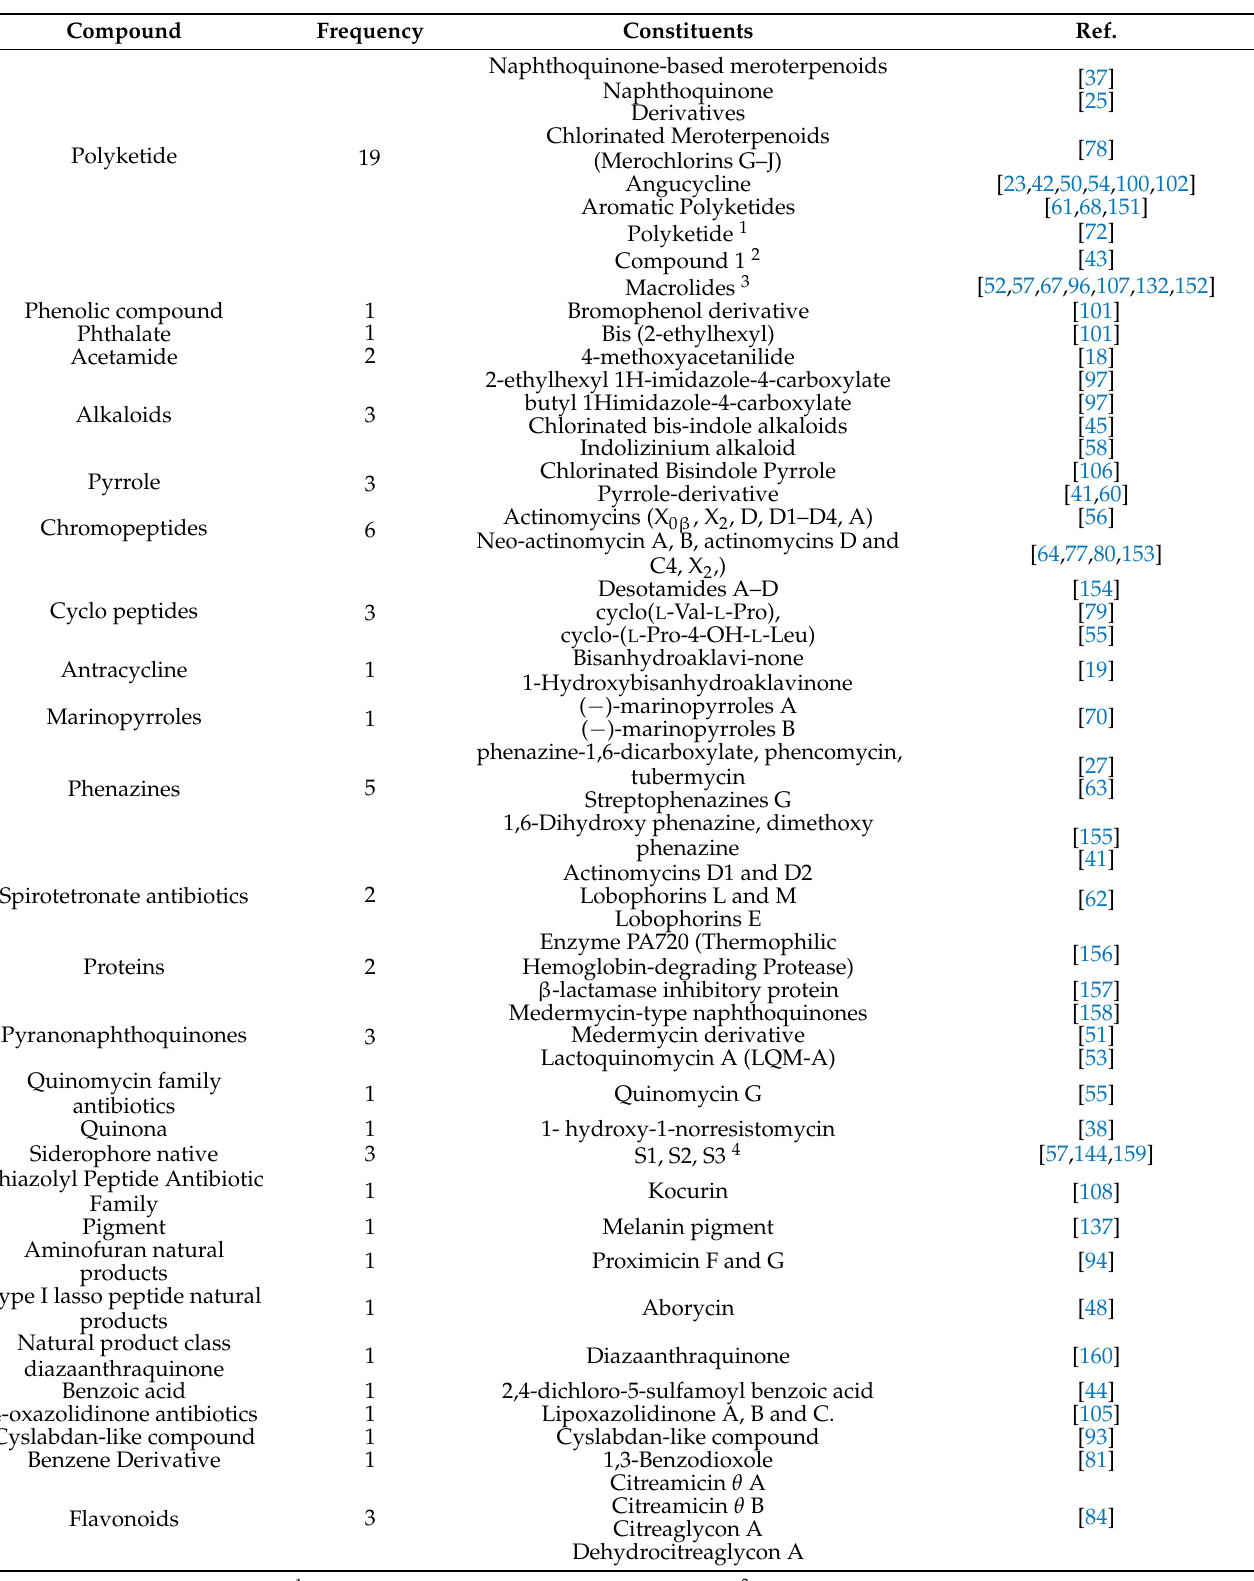
Table 6. Family compounds with antibacterial